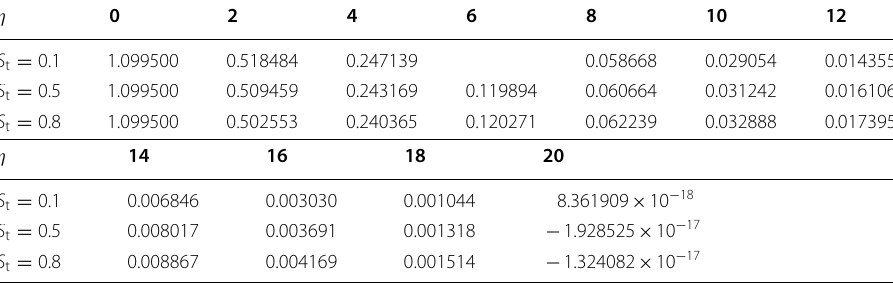
Table 5 Effect of Soret ( S t ) on the velocity profile η 0 2 S t = 0.1 S t = 0.5 S t = 0.8 η S t = 0.1 S t = 0.5 S t =